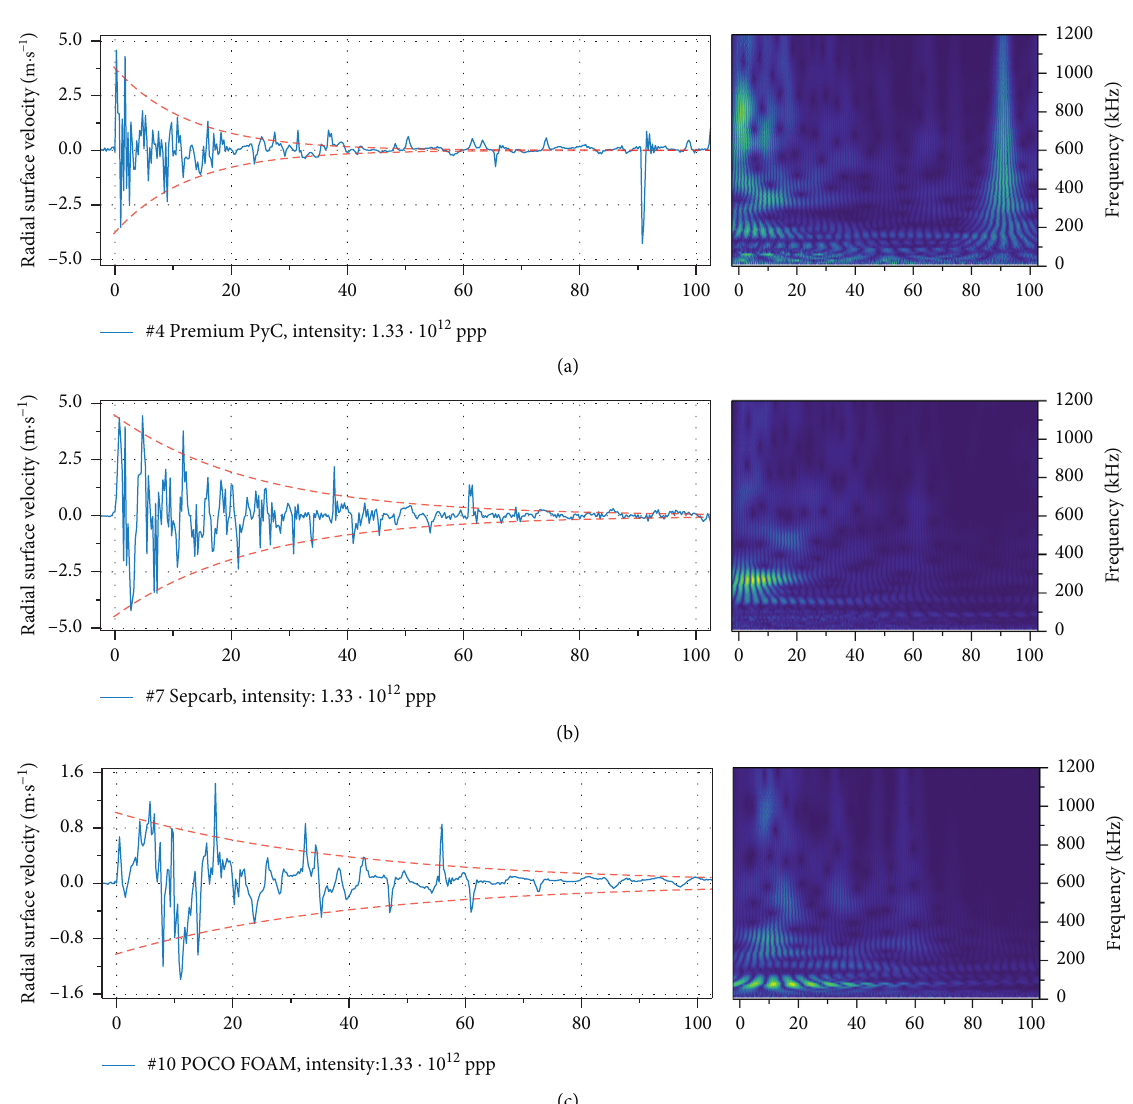
Figure 18: Radial surface velocity for maximum applied beam intensity for samples #4 Premium PyC (a), #7 Sepcarb (b), and #10 POCO FOAM (c). Left: recorded surface velocity (solid blue line) and calculated damping envelope (red dashed line). Right: continuous wavelet transformation as a function of time up to 100 μ s after beam